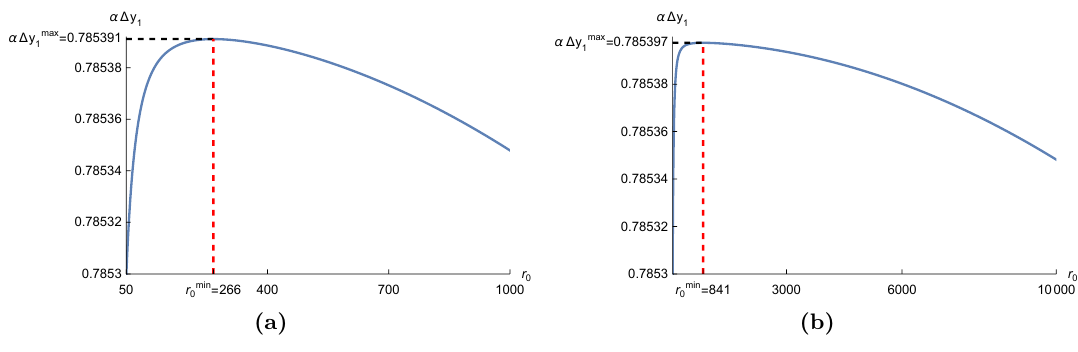
' 266 . (b) For r UV = 0 , given by eq. (B.13). 1